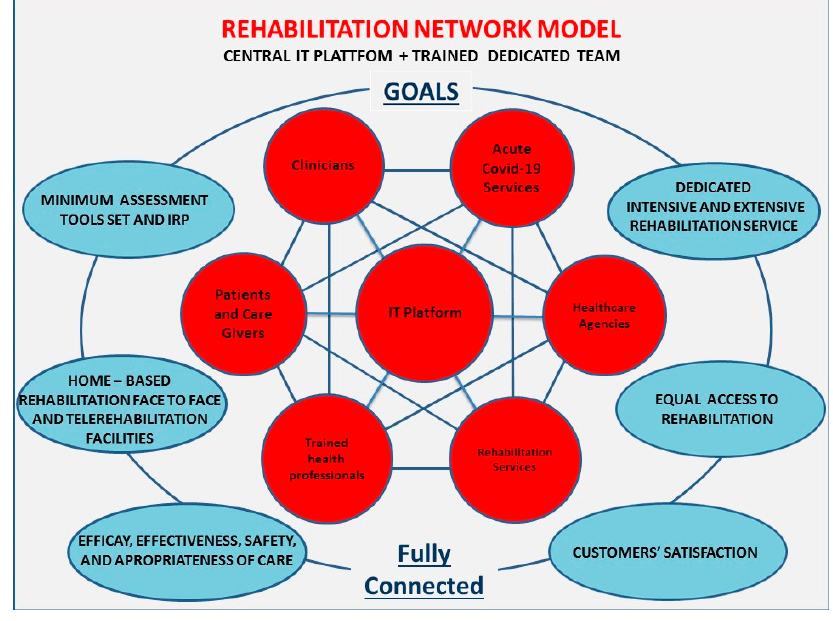
Figure 1. Rehabilitation Network Model.